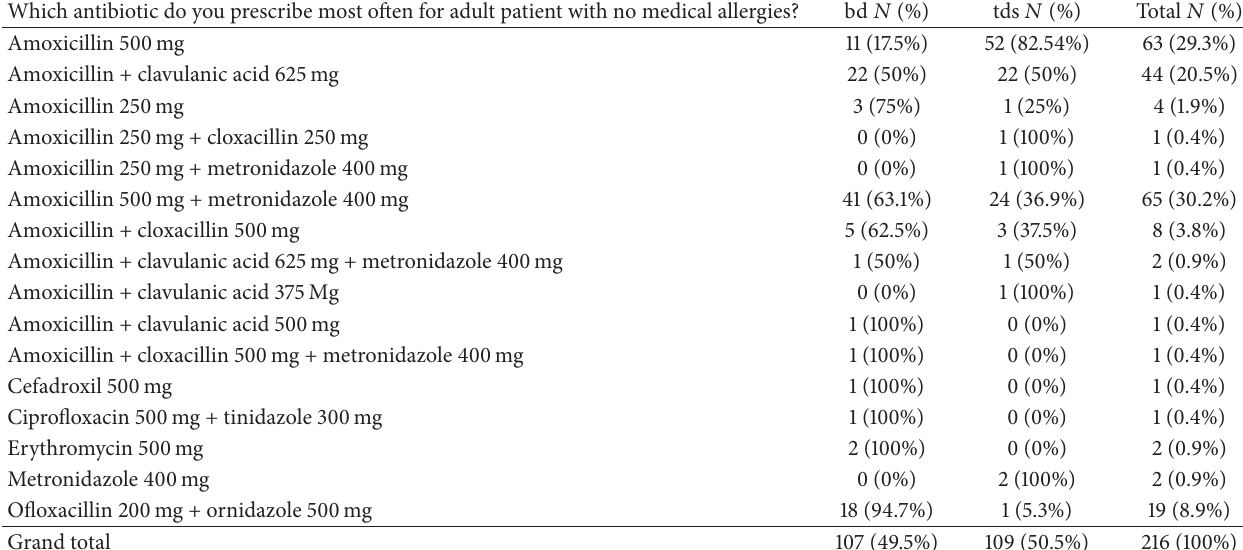
Table 2: Type, dose, and frequency of antibiotic prescription for an adult patient with no allergy to penicillin. Which antibiotic do you prescribe most often for adult patient with no medical allergies?